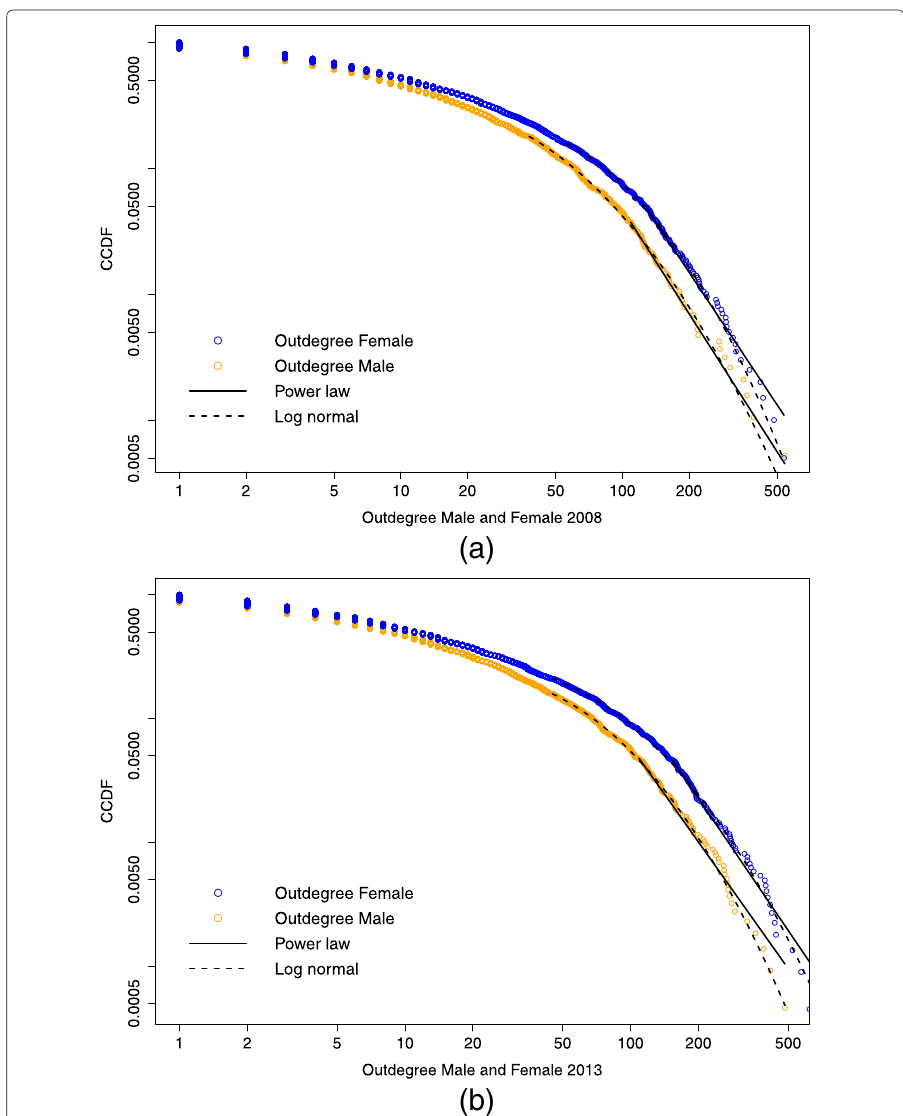
Fig. 10 2008 and 2013 outdegree distributions compared by gender. Complementary cumulative distribution function (CCDF) on log-log scale of the female and male outdegree distribution for the years 2008 (a) and 2013 (b). For each empirical distribution, the plots display also the lines of fit for a power law and a lognormal distributional